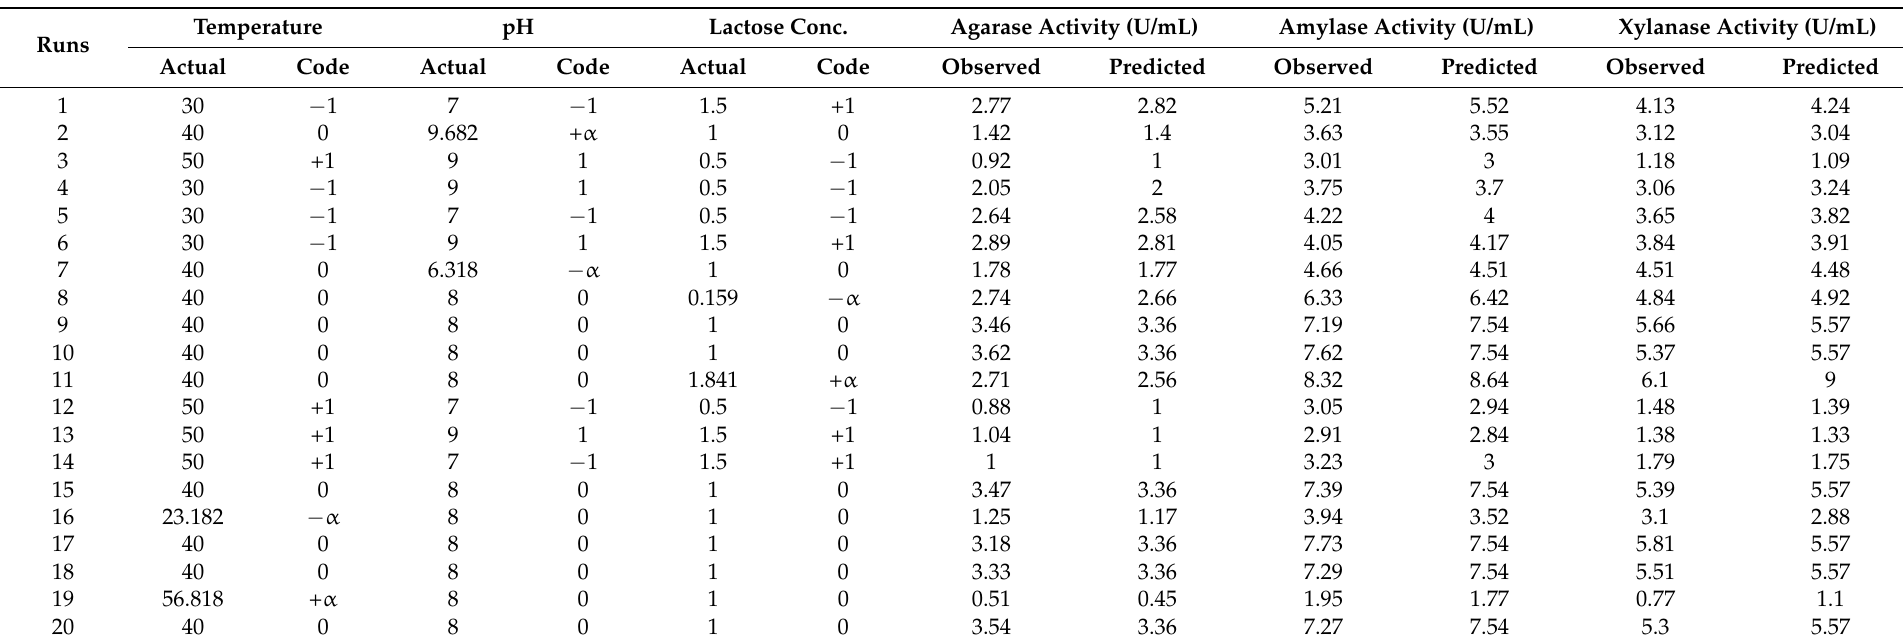
Table 4. The observed and predicted values for co-production of agarase, amylase and xylanase in CCD with coded units and real